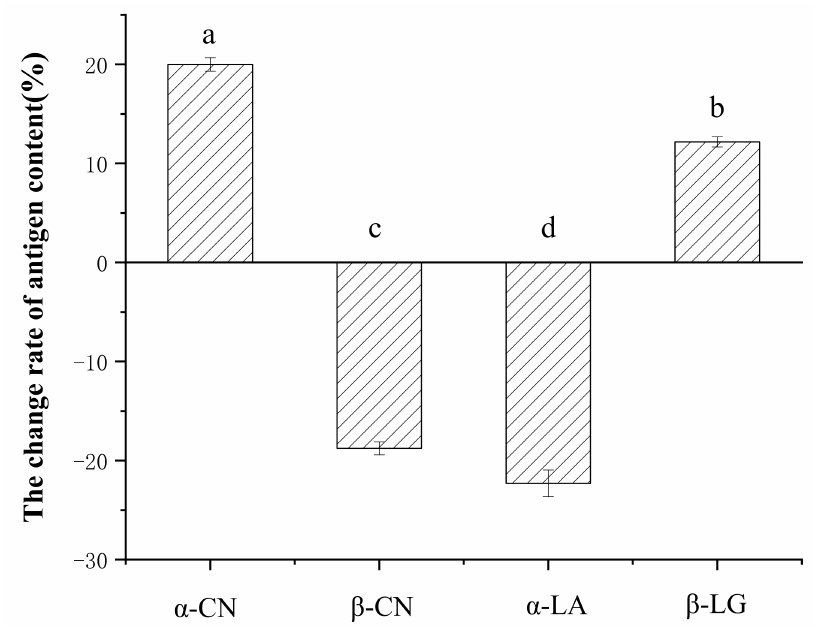
Figure 7. Changes in different milk protein antigens after pasteurized milk fermentation by ELISA. Bars with lowercase letter are significantly different ( p < 0.05) ( n =